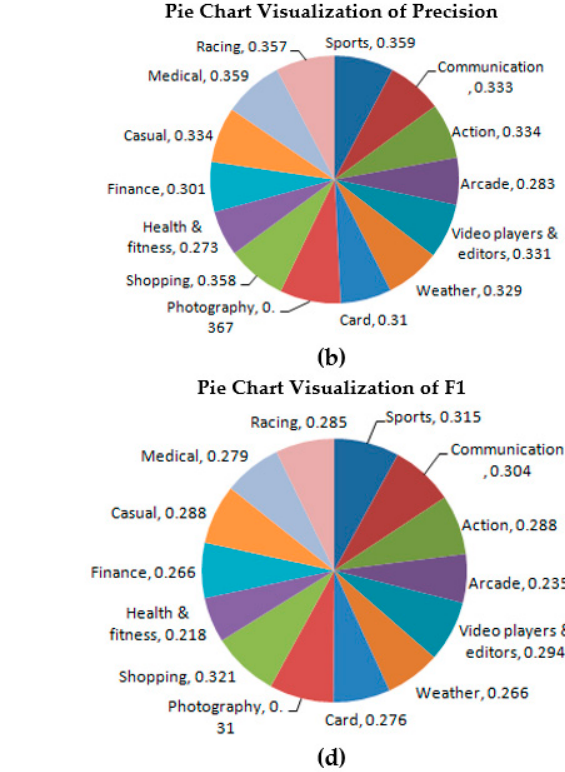
Figure 6. Pie chart visualization of different machine-learning algorithm comparison of TF-based data after preprocessing.